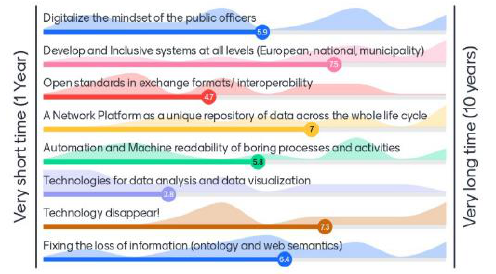
Figure 2. Ambitions for Technology in a 10 years' time frame.